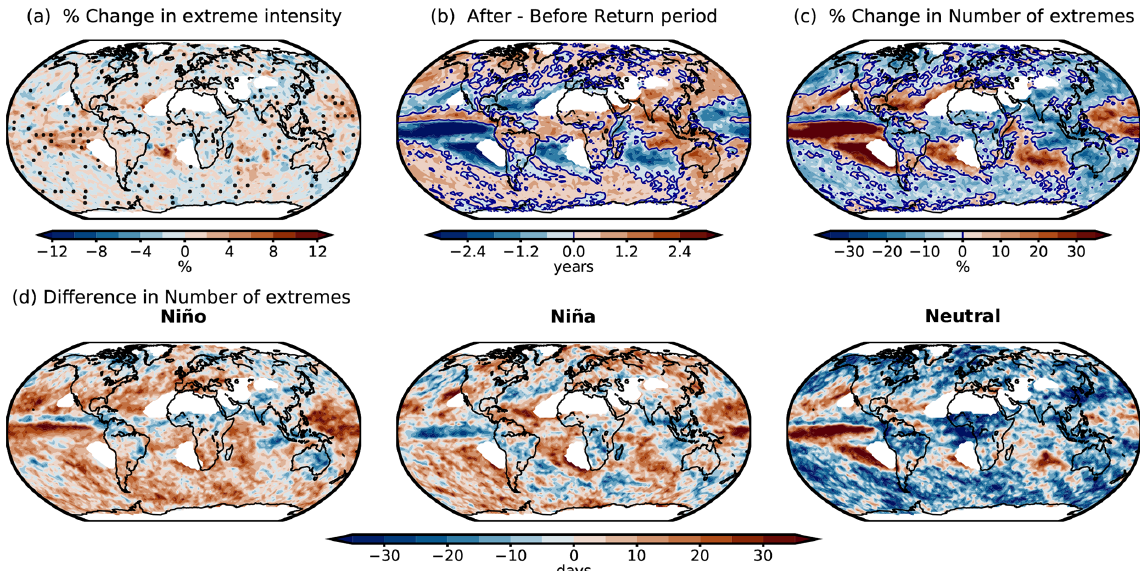
Figure 10. (a) Rates of change in the mean extreme precipitation, (b) differences in return periods, and (c) rates of change in the number of extreme precipitation during the period of 3 years after the tropical volcanic eruptions relative to 3 years before the tropical eruptions. The dotted regions in panel (a) indicate where the distributions of extreme precipitation between the pre- and post-eruption periods are statistically similar at the 99% confidence interval based on the M-W U test. (d) Rates of change in the number of extremes in different ENSO states during the years of tropical eruptions (year 0) relative to the same ENSO states during the year before the tropical